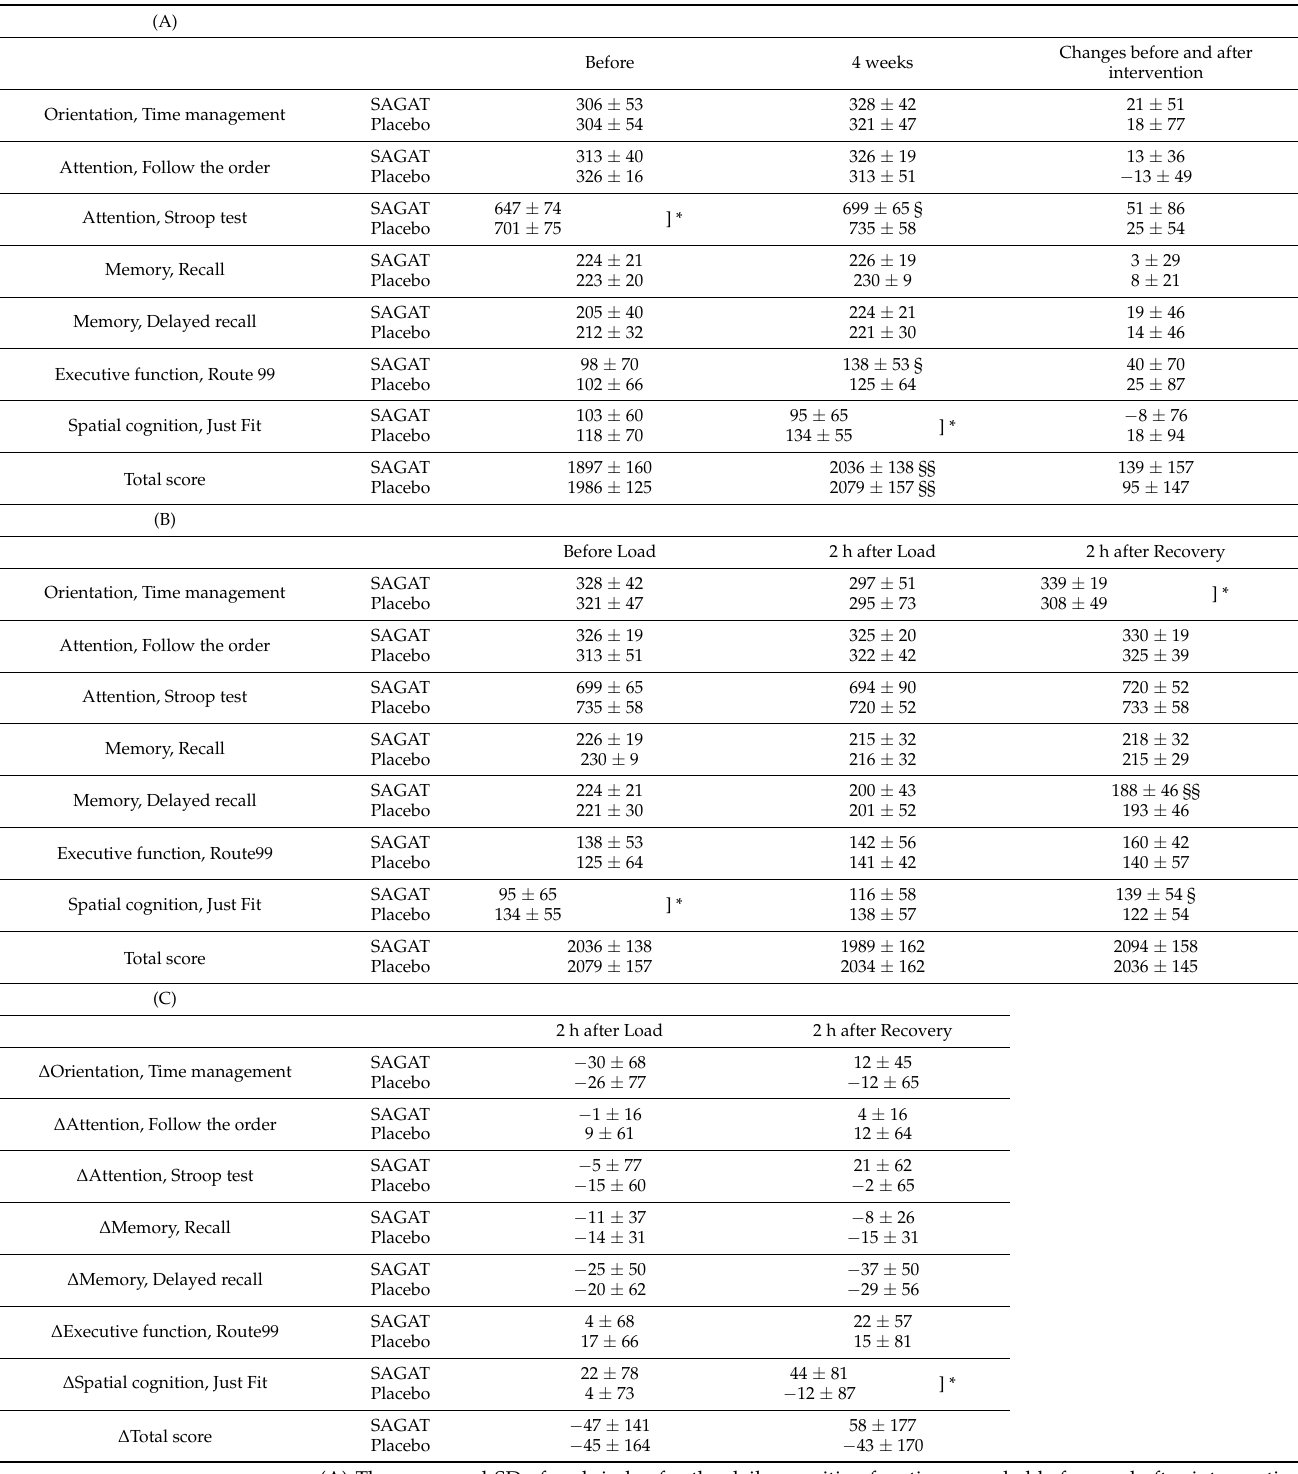
Table 5. Cognitive